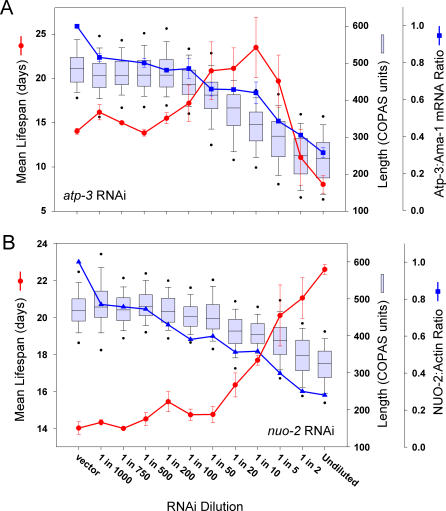
Effect of Increasing ETC Impairment on the Lifespan of atp-3 and nuo-2 Mit MutantsRNAi dilution series for atp-3 (A) and nuo-2 (B) were established using N2. Adult length (box plots in [A] and [B] show median [line], 10th–90th percentile [whiskers] and 5th–95th percentile [black dots]), mean adult longevity (± standard error of the mean [SEM], red line with circles), and total atp-3 mRNA content (±SEM, blue line with squares), or NUO-2 protein level (blue line with triangles) were assessed for worms at each RNAi dilution (see Figure S1 for decomposition of averaged data). All animals reached adulthood except those on undiluted atp-3 RNAi (see Figure 9). At an RNAi dilution of 1:50 for atp-3, and 1:20 for nuo-2, mean lifespan began to increase significantly (p < 0.05). Adult length is specified in linear COPAS units, and 500 COPAS units approximates 1 mm.